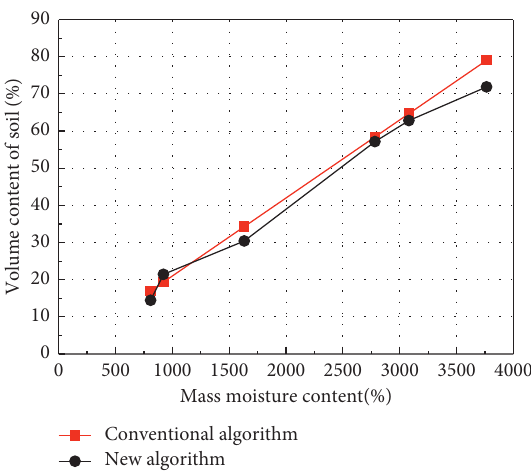
Figure 11: Comparison of two algorithms for the phenolic thermal insulation board.